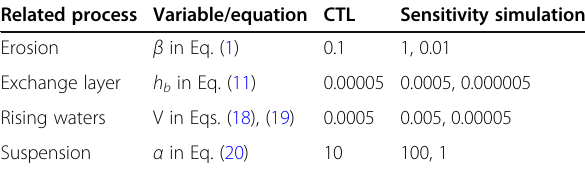
Table 3 Parameter values for CTL and sensitivity simulations Related process Variable/equation CTL Sensitivity simulation